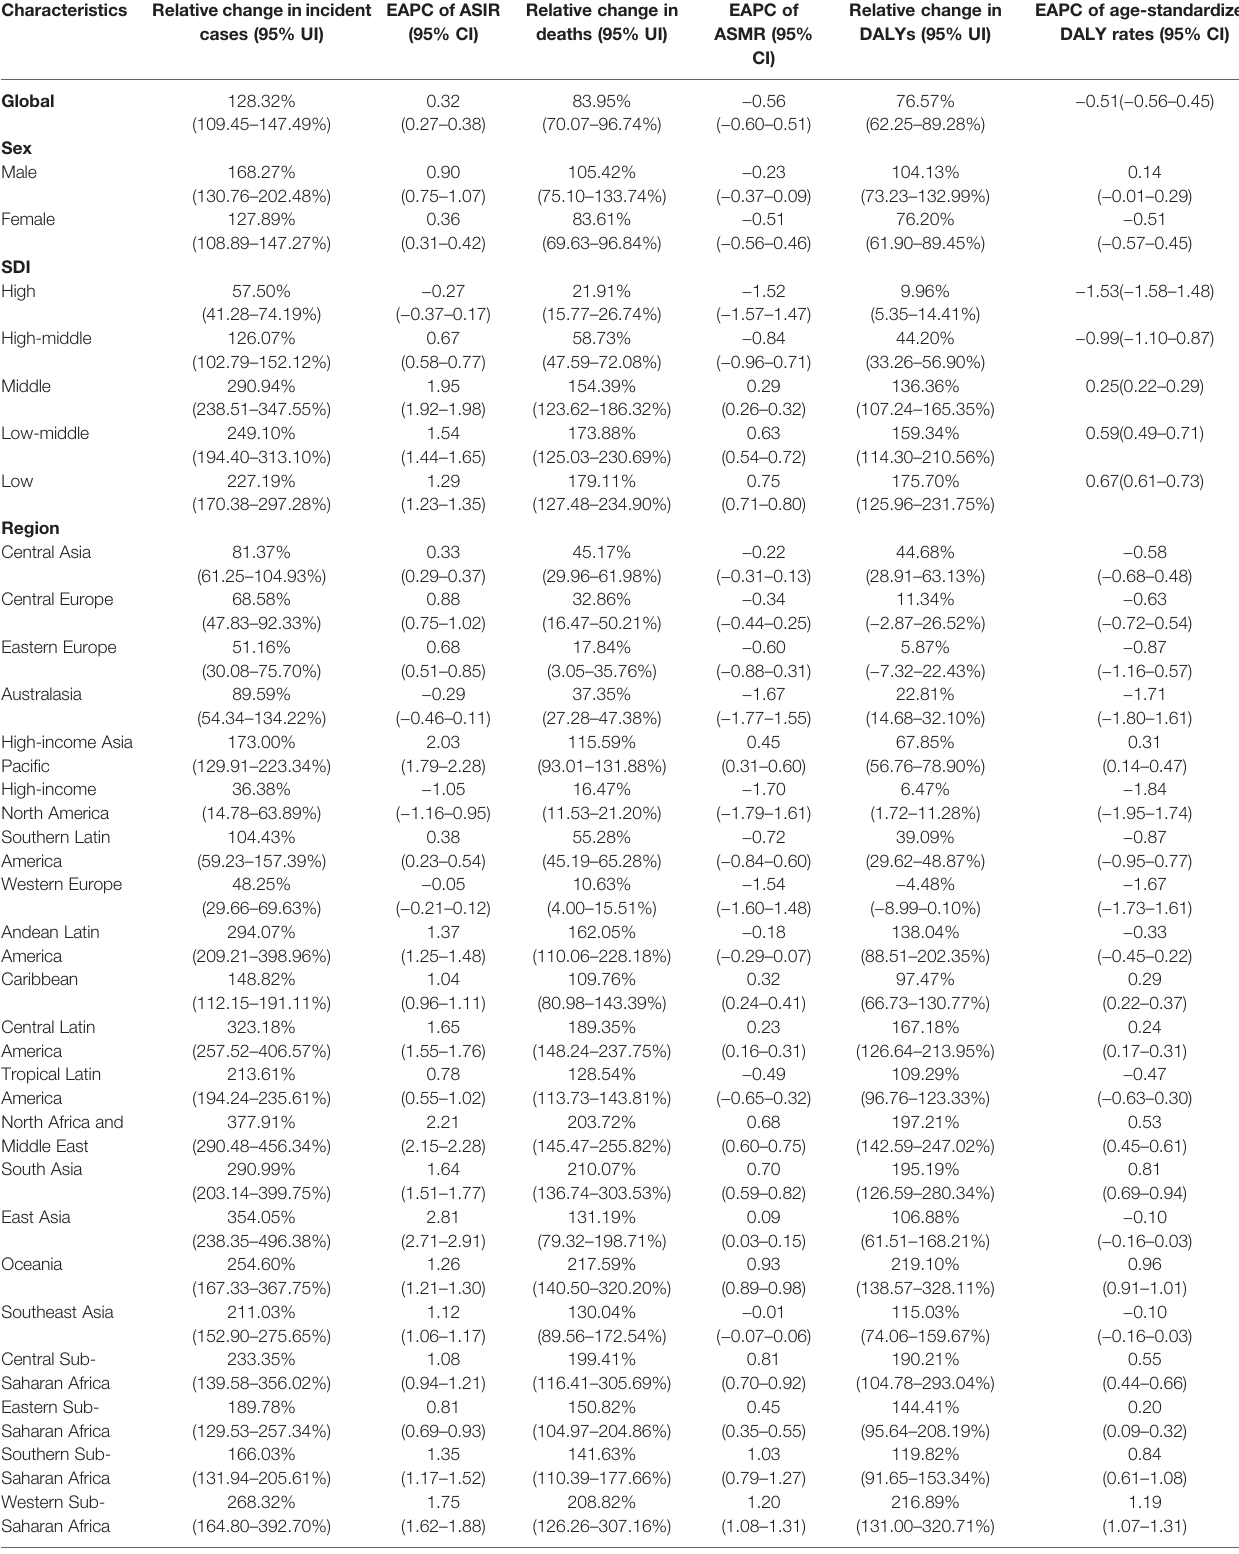
TABLE 2 | The trends in incidence, mortality and DALYs of breast cancer between 1990 and